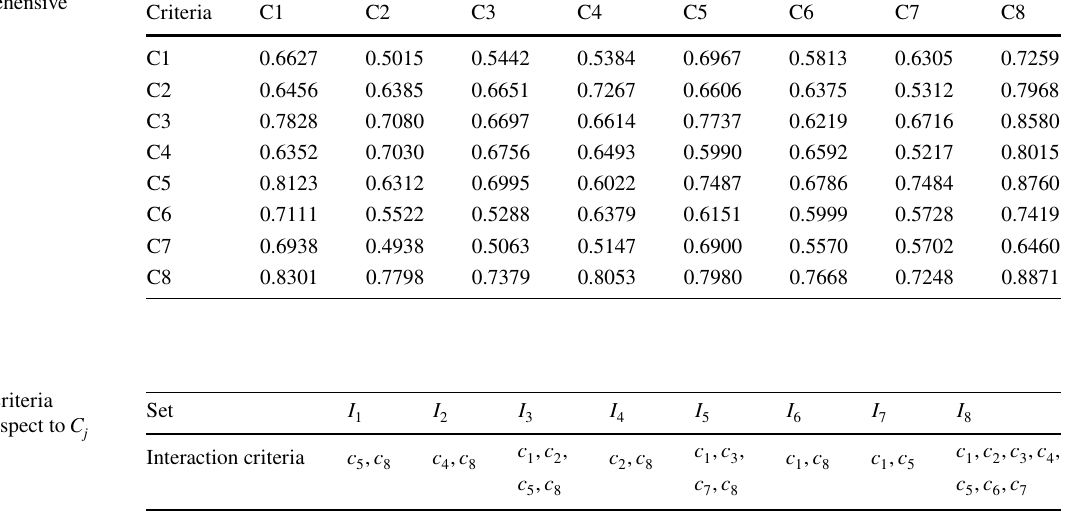
impact matrix M